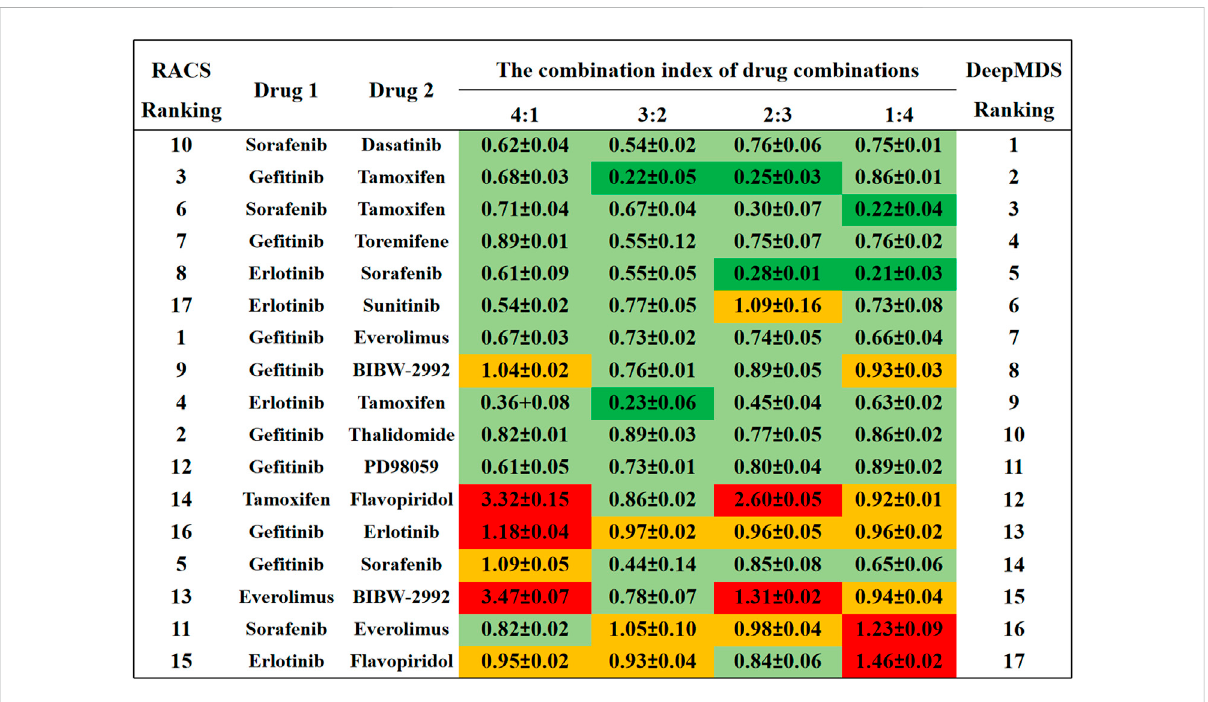
FIGURE 3 The comparison results between DeepMDS and literature. The synergy effect of each drug pair was retrieved from literature (Sun et al., 2015), anddescribedusingcombinationindex(CI).TheleftrankingwaspredictedusingRACSmodel, validatedby invitro experimentsonMCF-7(Sunetal., 2015). Dark green indicated strong synergy (CI < 0.3); pale green indicated synergy (0.3 < CI < 0.9); yellow indicated additive (0.9 < CI < 1.1); and red indicatedantagonism(CI > 1.1).The differentCI valuesofeach drugpair werecalculated atfourdual-drug ratios,including 4:1,3:2,2:3,